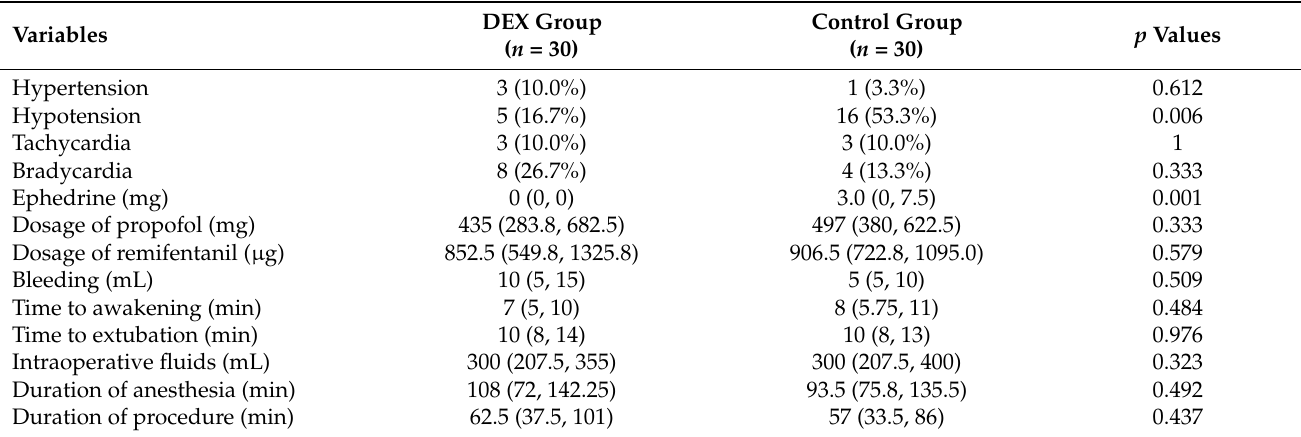
Table 3. Anesthesia and intraoperative data.